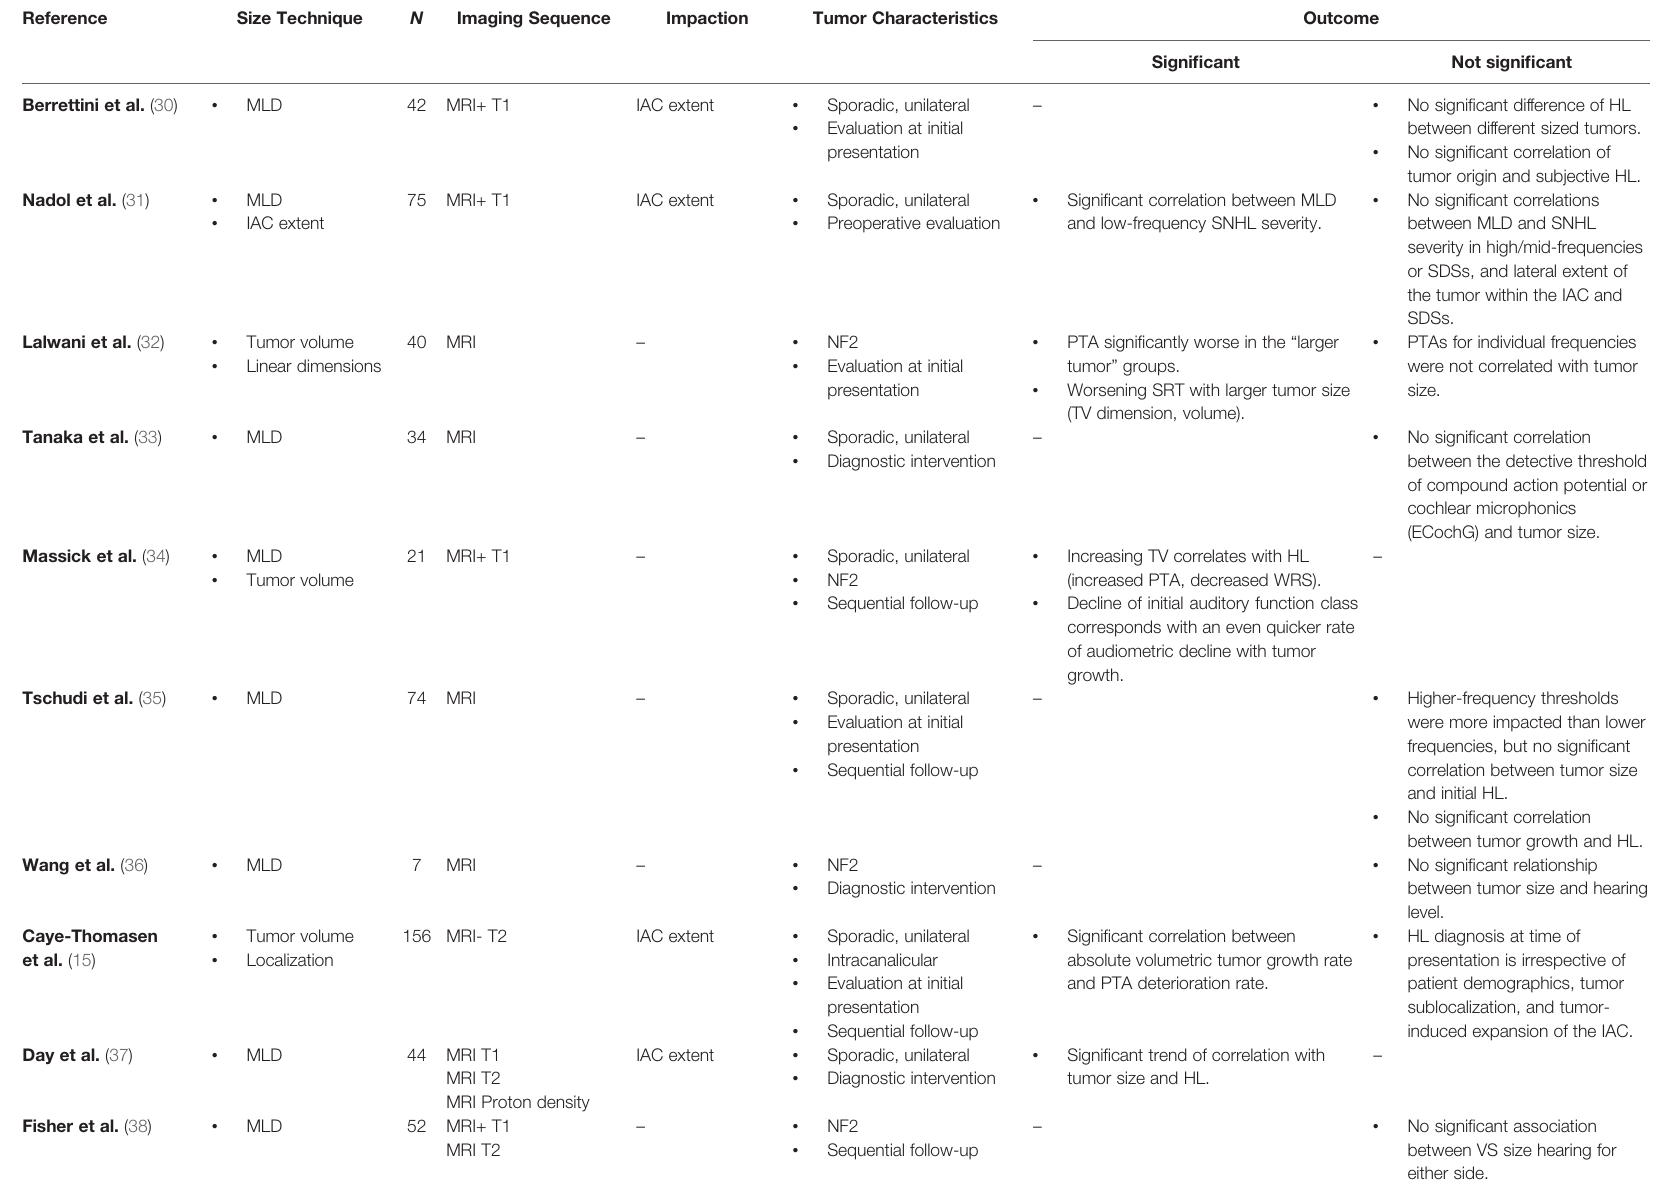
TABLE 2 | Summary of historical analyses of hearing loss vs. imaging characteristics in patients with vestibular schwannoma. Reference Size Technique N Imaging Sequence Impaction Tumor Characteristics